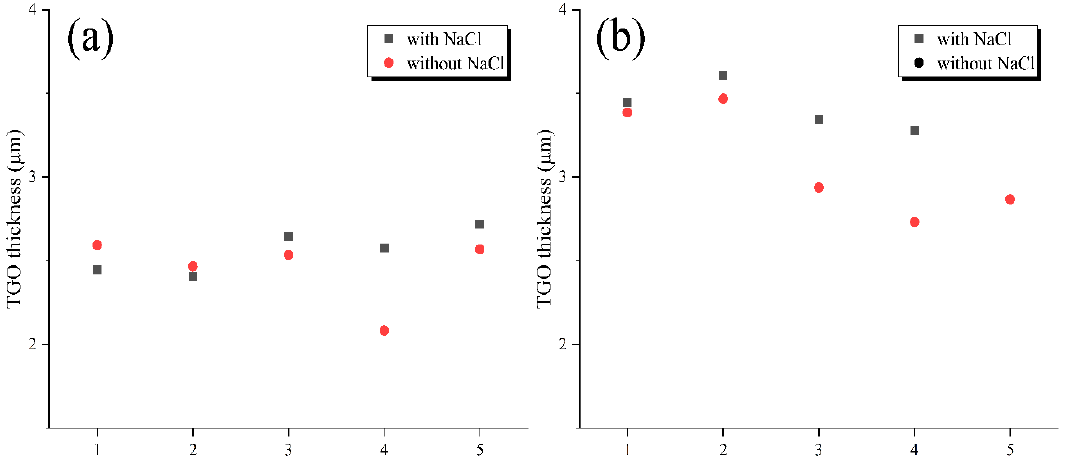
Figure 14. TGO thickness of YSZ after ( a ) four cycles and ( b ) eight cycles at five optional positions of the edge.